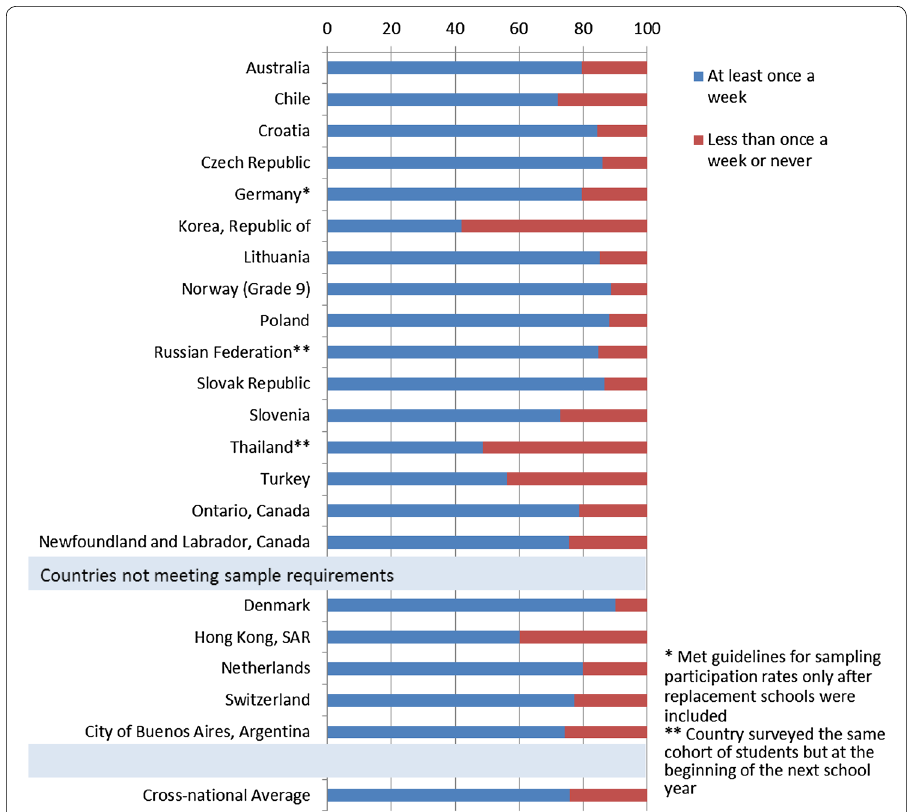
Fig. 6 Proportion of students by use of ICT for communicating with others using messaging or social net-